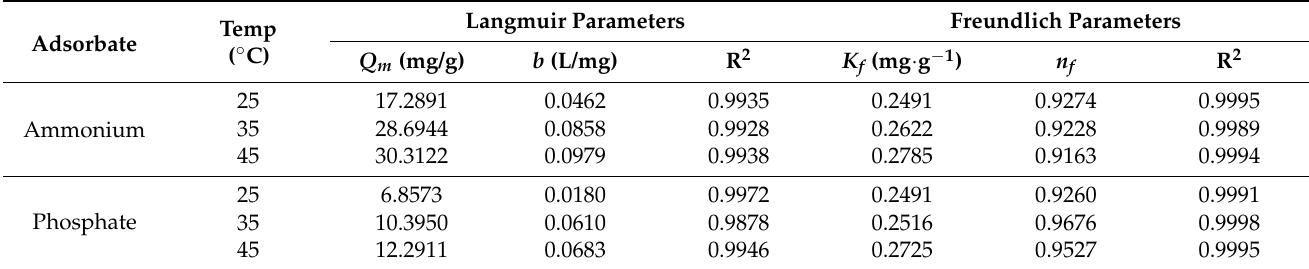
Figure 12. Langmuir isotherm plots for the adsorption of ammonium ( a ) and phosphate ( b ) onto the SOD. Table 4. Langmuir and Freundlich isotherm parameters.